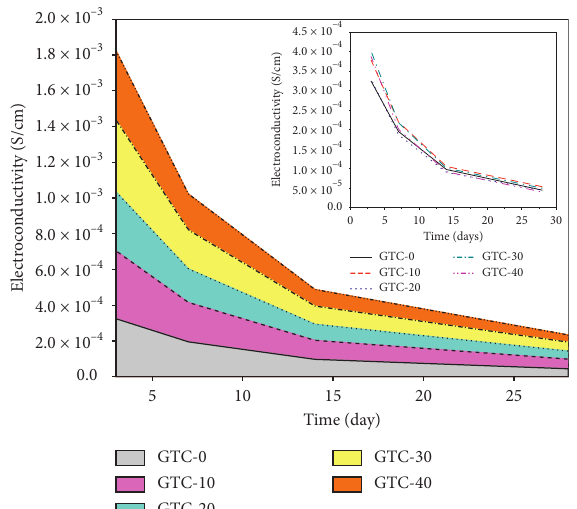
Figure 6: Electroconductivity of GTC (0% to 40%) in different curing days. Figure 13. The peak value of the pore size distribution of GTC-10 was the lowest and that of GTC-40 was the highest. The area integral values of the MIP curves decreased from 1879.64 mL · nm/g to 1722.58 mL · nm/g and increased to 2150.85 mL · nm/g. This trend implies that the pore structure of GTC becomes unstable with the increase in the content of graphite tailings. The porosity, median pore size, average pore size, most probable pore size, and total pore area with different contents of graphite tailings are shown in Table 6.